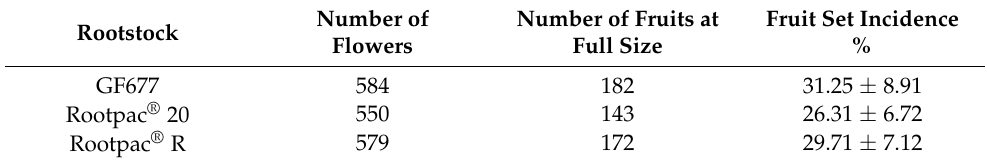
Table 5. Percentage of fruit set of plants in trial B (cultivar ‘Guara’), calculated at the end of April 2021. Data are reported as mean ± standard deviation. Different lowercase letters on the columns indicate significant differences among rootstocks (Fisher’s test p < 0.05). (2021).